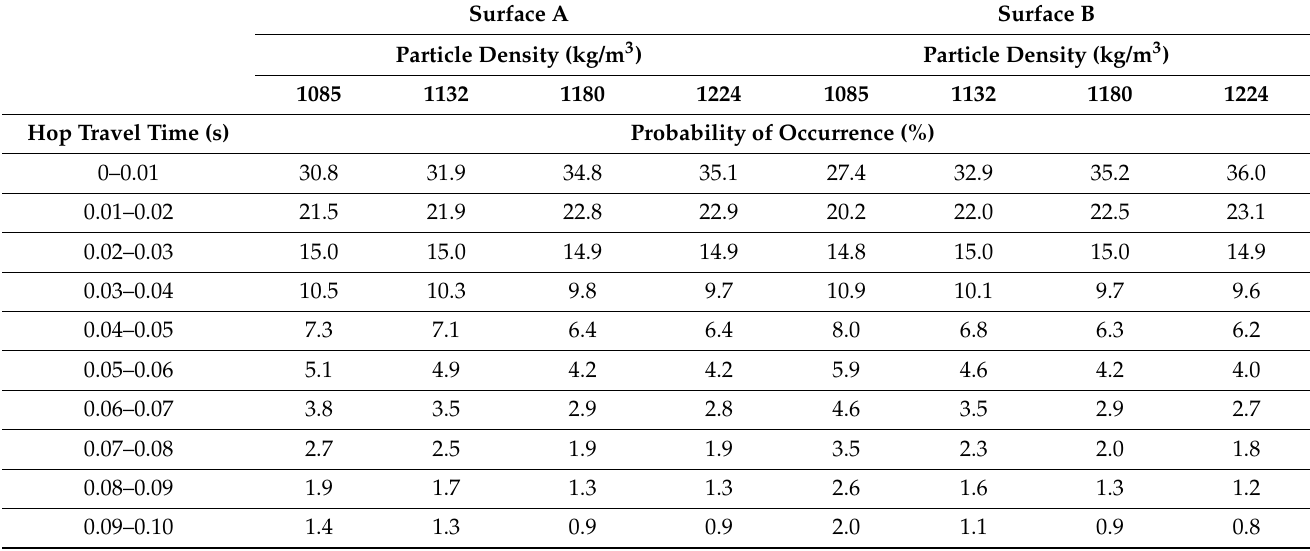
Table A3. The effect of different particle densities on the travel time exponential distribution model parameters, for bed surface A (and Reynolds number of 50,789), and bed surface B (and Reynolds number of 51,488). These tabulated data correspond to the results plotted in Figure 13b,d.